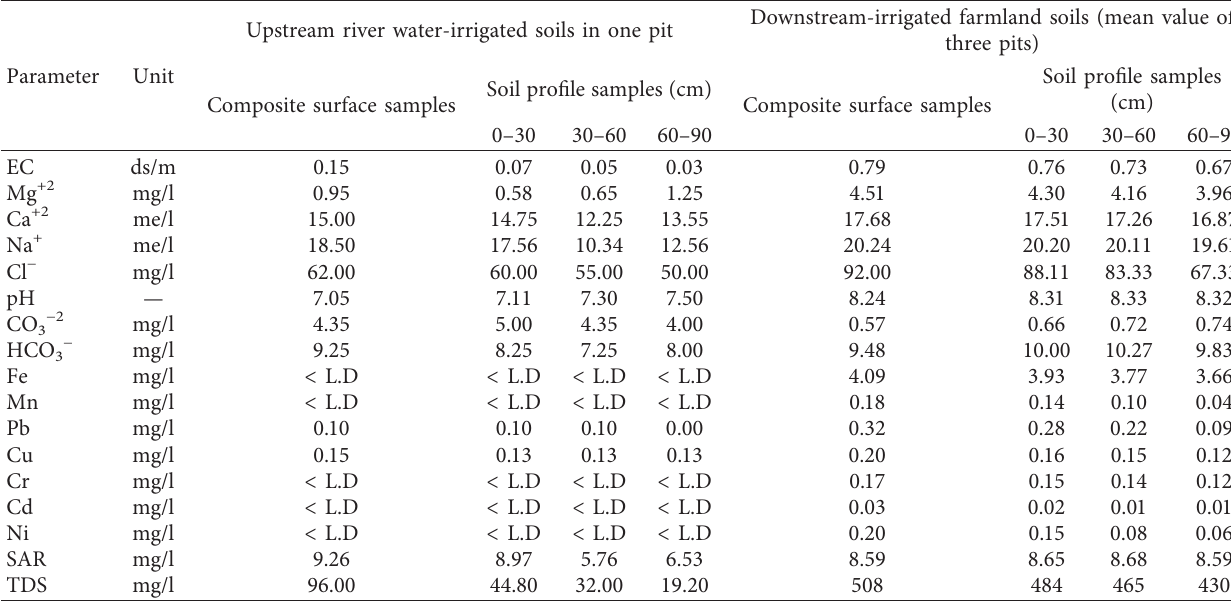
Table 7: The characteristics of upstream and downstream Borkena irrigated farm soils.